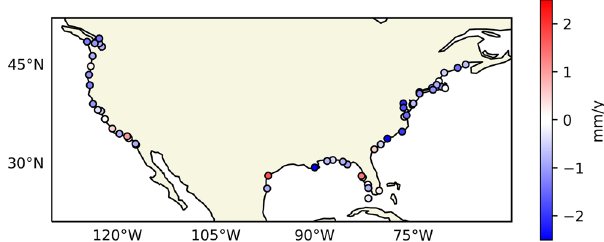
Fig. 5 Trend residuals. Map of the residual sea-level trend estimated as the difference between the combined trend contributions from contemporary mass redistribution, sterodynamic effects, and vertical land motion and the corrected tide-gauge trend following Eq.